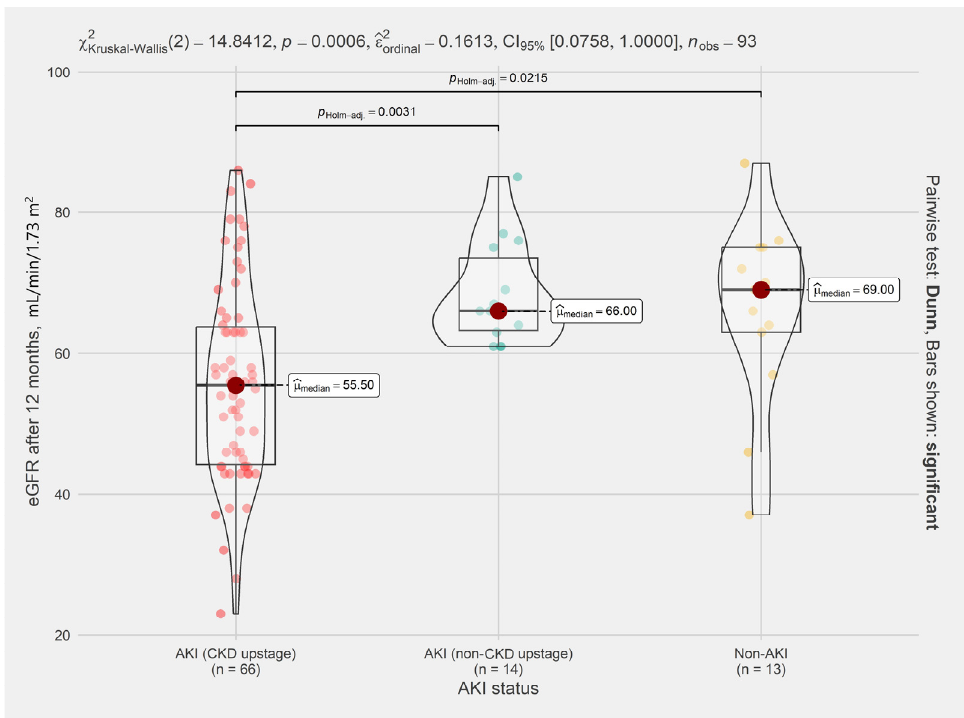
Figure 6. The effect of postoperative clinically significant AKI on eGFR 12 months after RN. Abbreviations: CKD—chronic kidney disease; eGFR—estimated glomerular filtration rate; AKI—acute kidney injury .